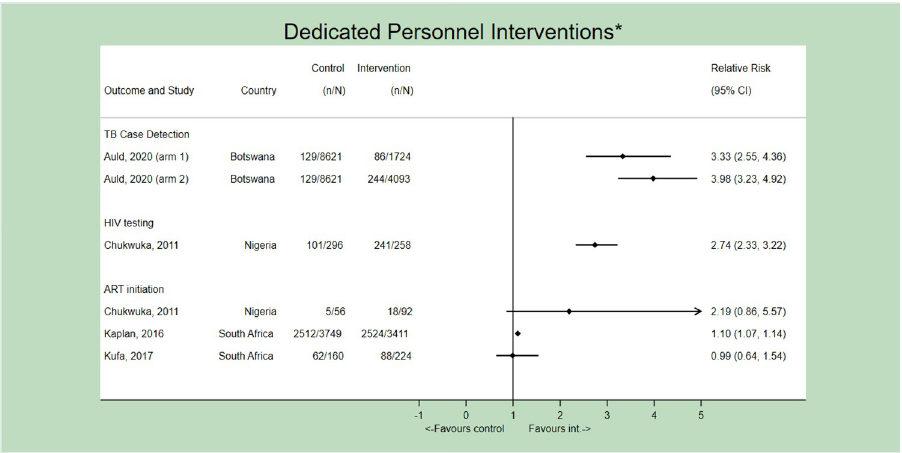
Fig 5. Forest plot (not pooled) depicting the effect of dedicated personnel interventions on all outcomes. � All studies implemented concurrent interventions and/or SOC strategies. Only the first author of each study is listed.